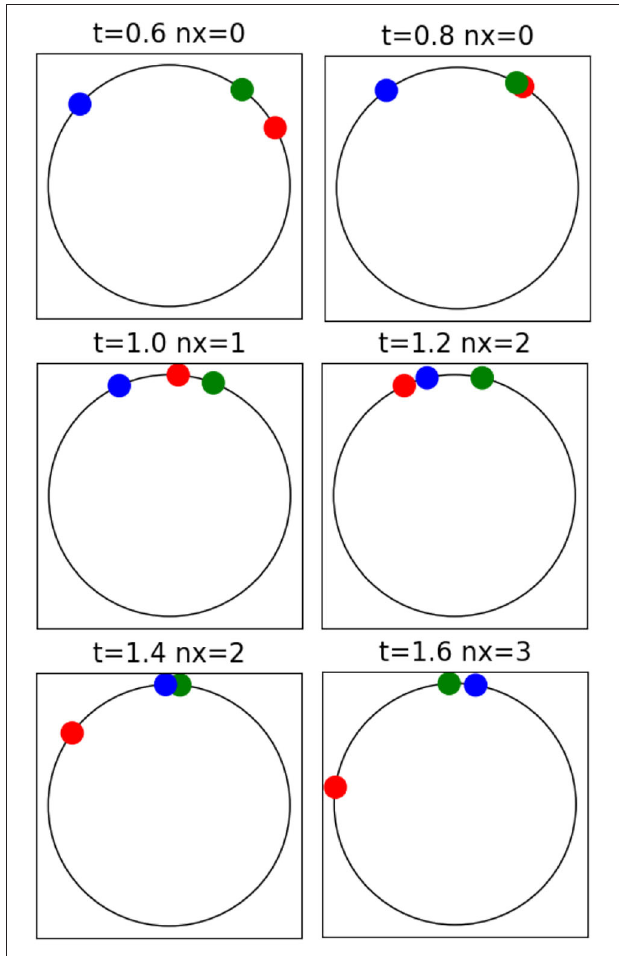
FIGURE 1 | Example of encounters between walkers on a circular track. The blue walker moves in the clockwise direction and the green and the red walkers move in the counter-clockwise direction, the red walker moves faster than the green. The time and the number of encounters up to that instant are shown above each